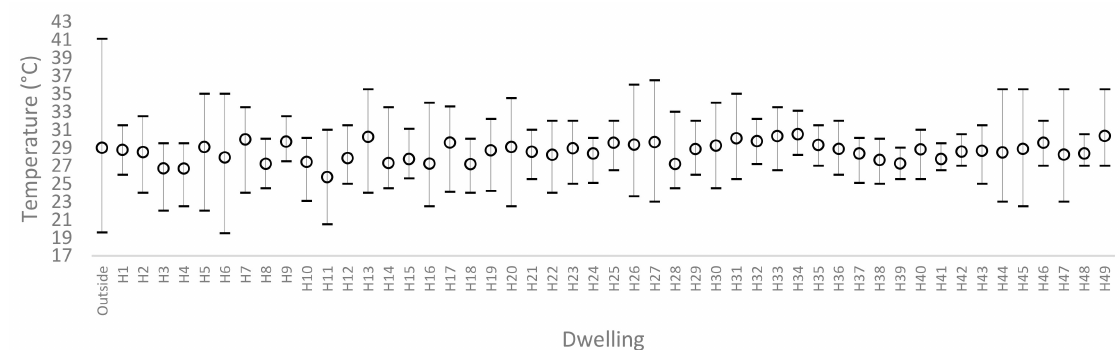
Figure 1. Minimum, maximum, and mean temperatures in living rooms of each monitored dwelling during the summer.